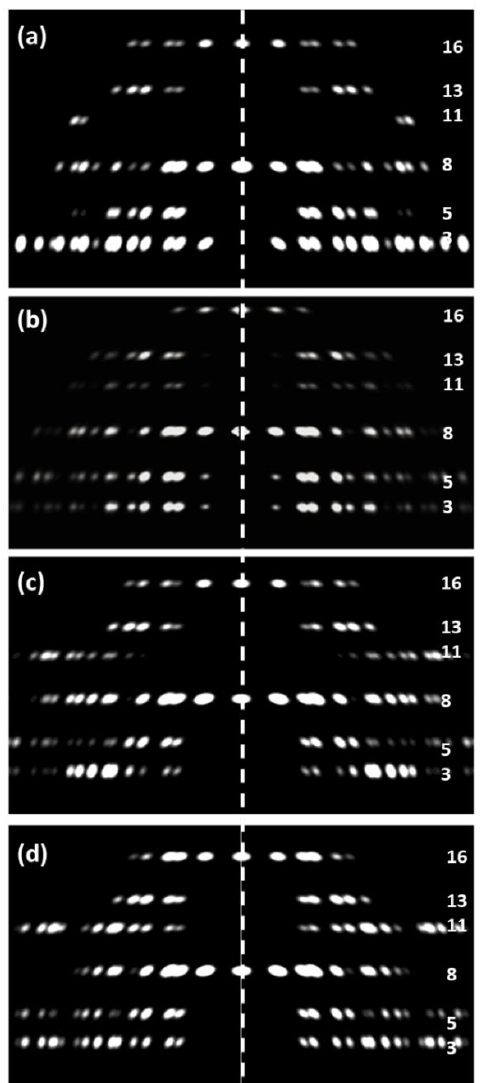
Figure 10. Comparison of three crown levels of the Hu et al. [27] insect flight muscle myosin filament density map ( a ) and the model ( b ) from AL-Khayat et al. [11] based on fitting X-ray diffraction data.